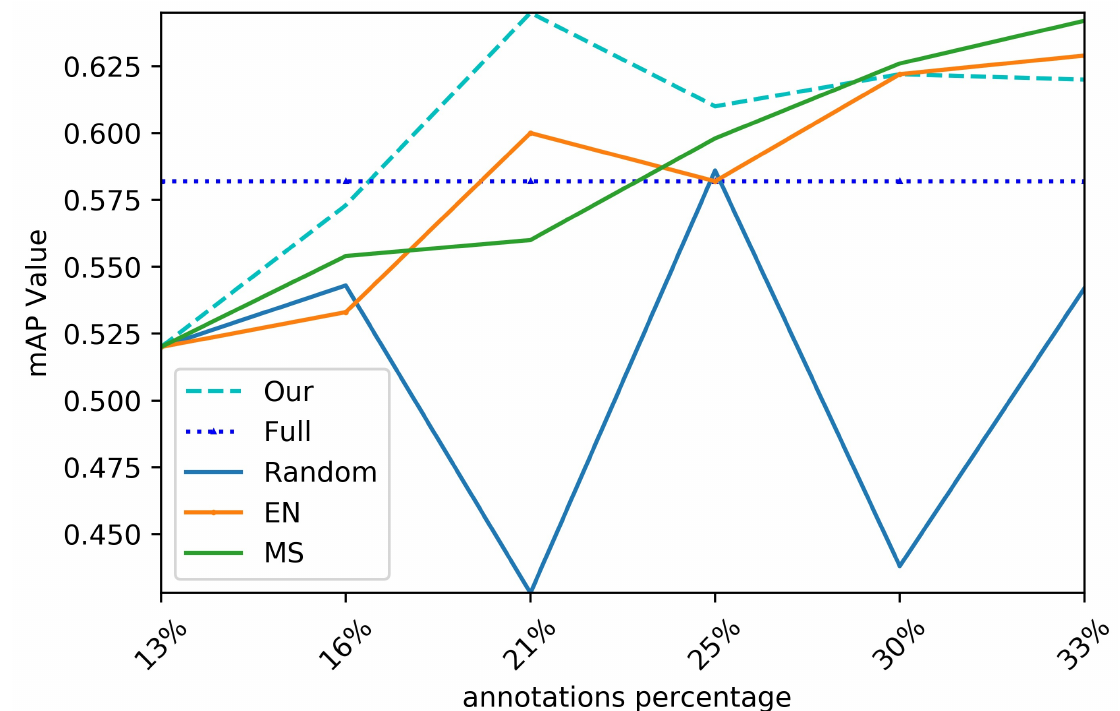
Figure 5. Comparison of mean Average Precision (mAP) for the different strategies. Table 4. The performance obtained via the full